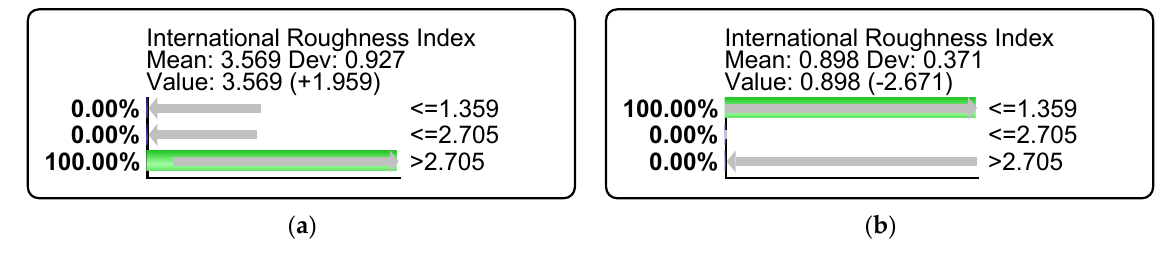
Figure 11. Scenarios tested for IRI: ( a ) case 1; ( b ) case 2.